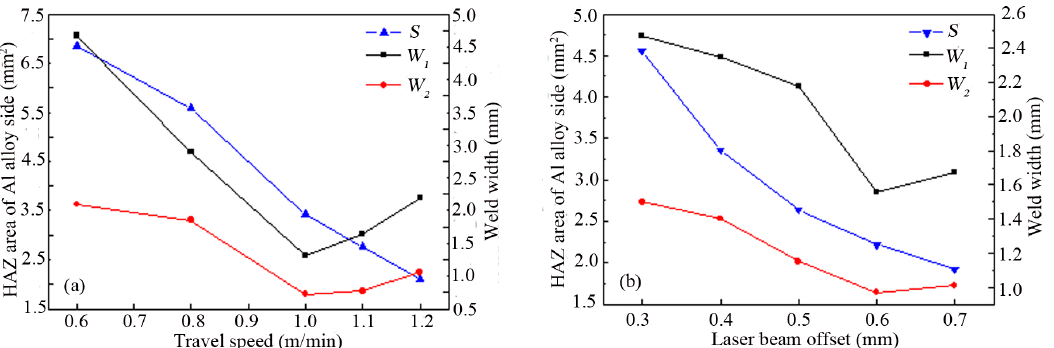
Figure 6. Relationship between process parameters and weld width or the heat-affected zone (HAZ) of the Al side: ( a ) travel speeds; ( b ) laser beam offsets. Blue color corresponds to HAZ; Black and red color correspond to top width ( W 1 ) and bottom width ( W 2 ) of the welds.